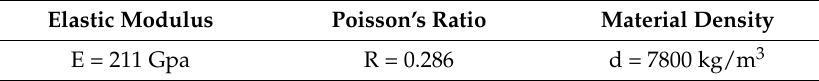
Table 1. The material characteristics of 316 L steel.